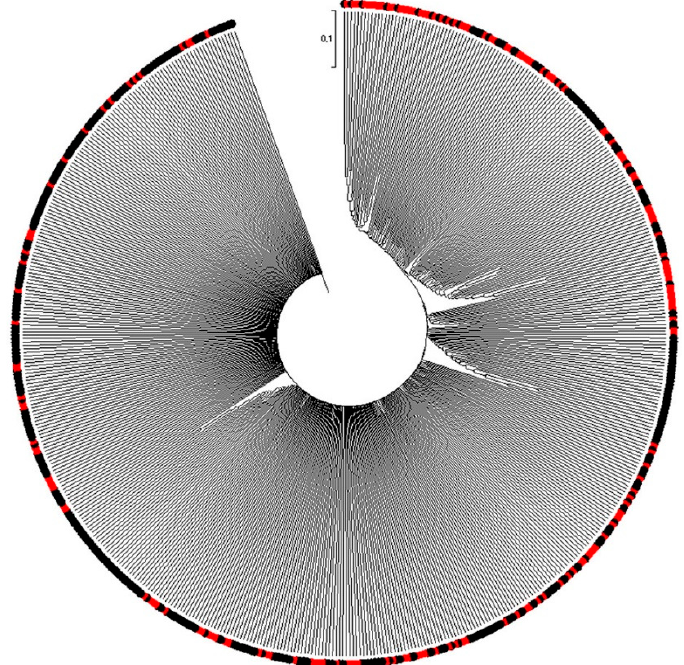
Figure 2. Unweighted pair-group method with arithmetical average (UPGMA) dendrogram of 548 rice germplasms based on 16 SSR markers using MEGA7 program. The red color in the boundary indicates rice genotypes that have red seeds and the black color indicates rice genotypes that have black seeds. Black and red rice are not clearly distinguished and mixed in large groups.